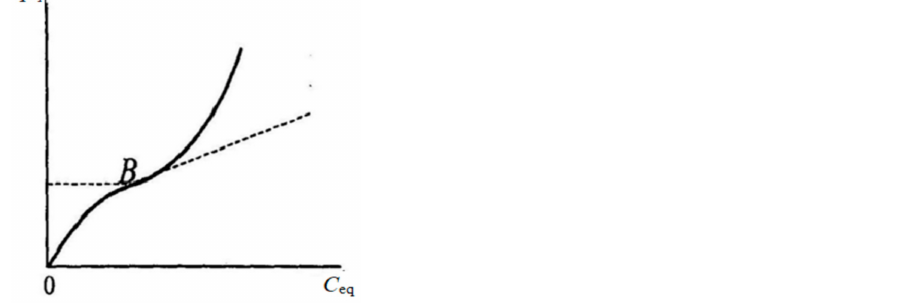
Figure 1. Determination of the capacity of a monolayer using the Brunauer point (point B )